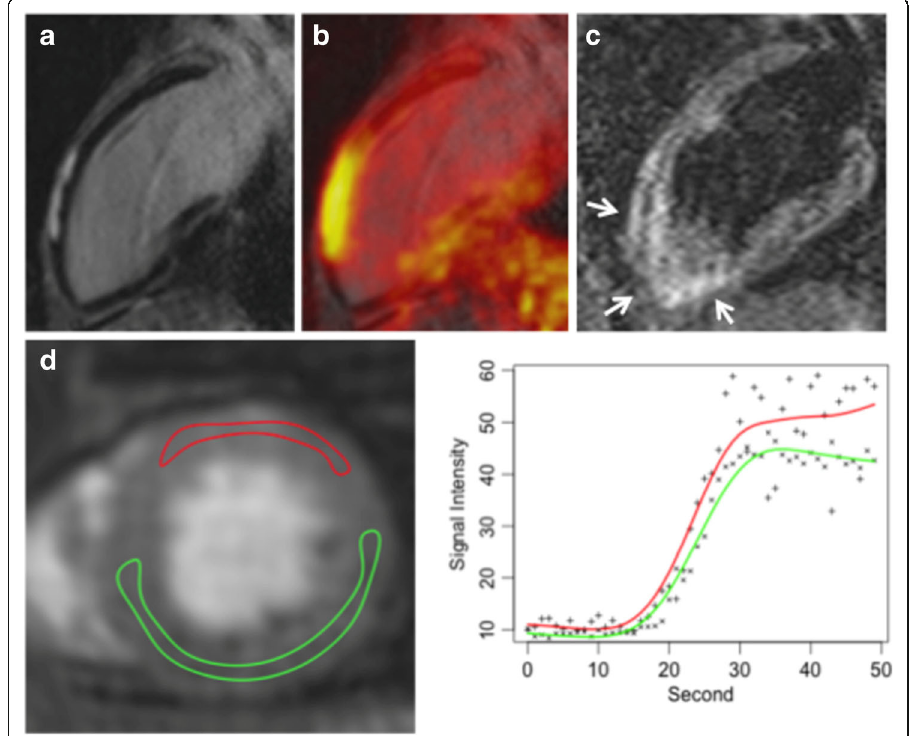
Fig. 5 18 F-FDG PET/MRI in a patient with acute viral myocarditis caused by parvovirus B19. (A) Late- gadolinium-enhanced MRI long-axis view demonstrating typical subepicardial enhancement in the anterior left ventricular wall that was in excellent spatial agreement with increased 18 F-FDG uptake on fused images (B). (C) T2-weighted images revealed an oedema in the LV anterior wall. (D) Dynamic perfusion imaging revealed hyperaemia in the LV anterior wall. (With kind permission from Ref 50-Nensa, Poeppel